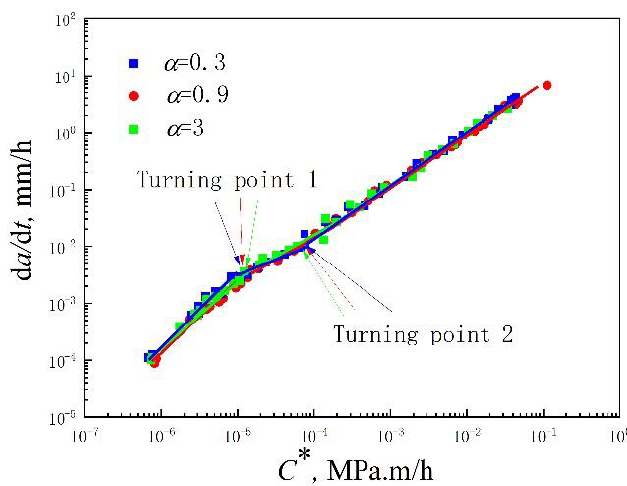
Figure 8. The effect of parameter α in the creep ductilities on the CCG rates.